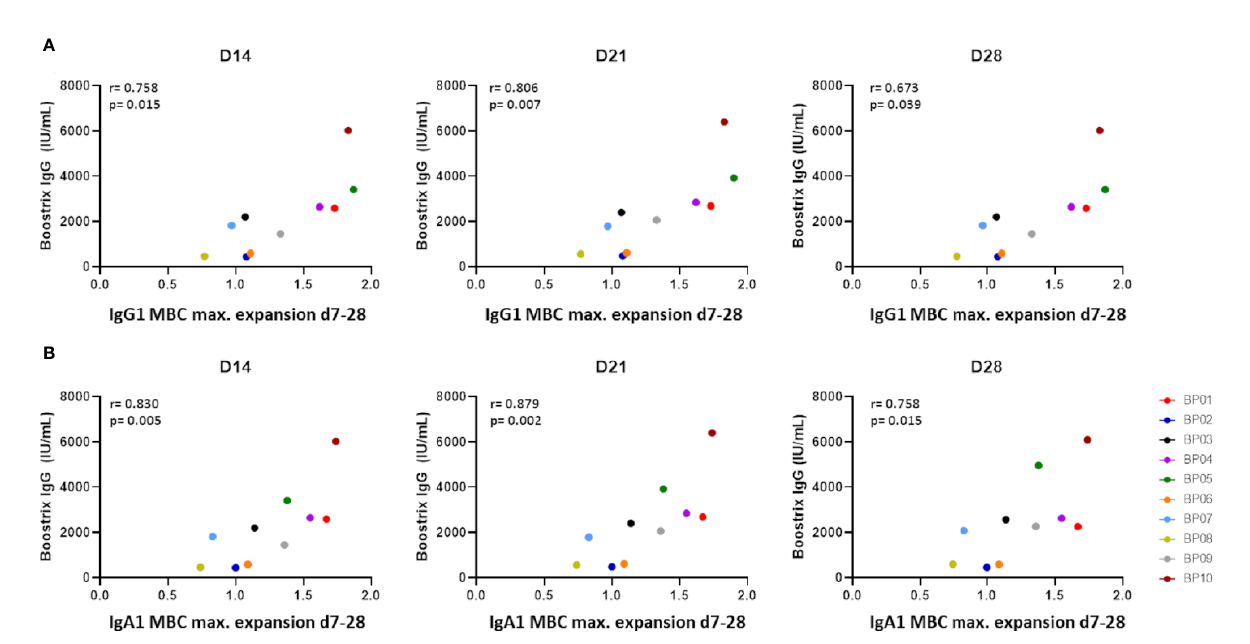
FIGURE 5 | Correlation between maximum expansion of memory B-cell subsets and vaccine-speci fi c IgGs as determined by Spearman ’ s rank correlation. (A) Correlation between the maximum expansion of IgG1 memory B cells (ratio over baseline at days 7-28) and vaccine-speci fi c IgGs ( “ Boostrix-IgG ” ) at days 14, 21 and 28. (B) Correlation between the maximum expansion of IgA1 memory B cells (ratio over baseline at days 7-28) and vaccine-speci fi c IgGs at days 14, 21 and 28. An FDR-corrected p-value of <0.0075 was considered signi fi cant. D, Days after